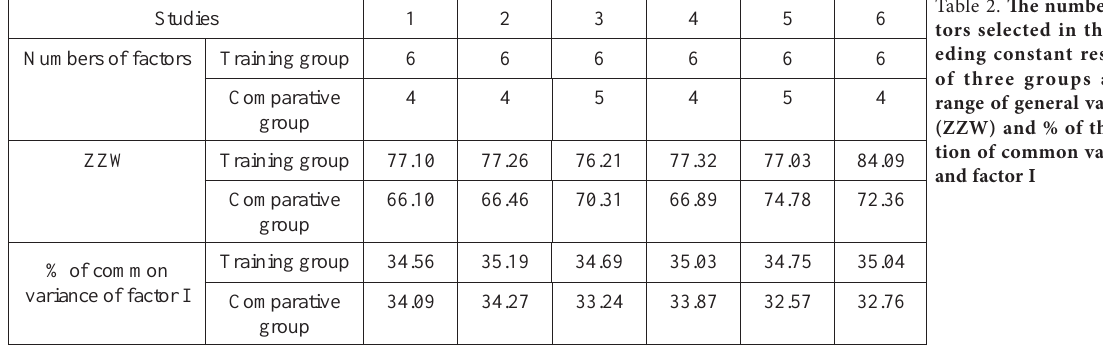
Table 2. Th e number of fac- tors selected in the succe- eding constant researches of three groups and